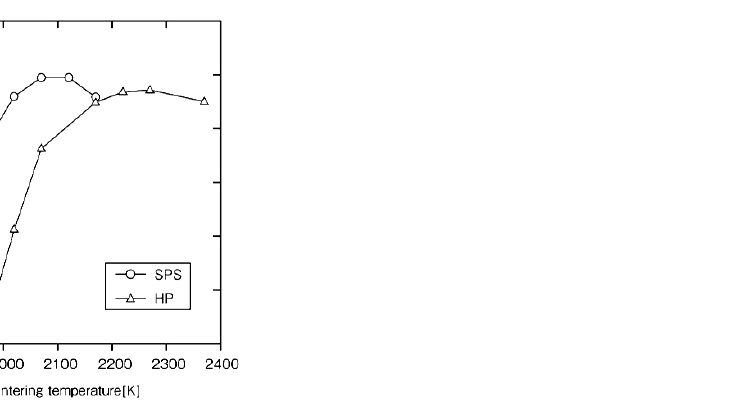
Figure 19. Dependence of bending strength on the sintering temperature in the SPS- and HP-con- solidated SiCs.